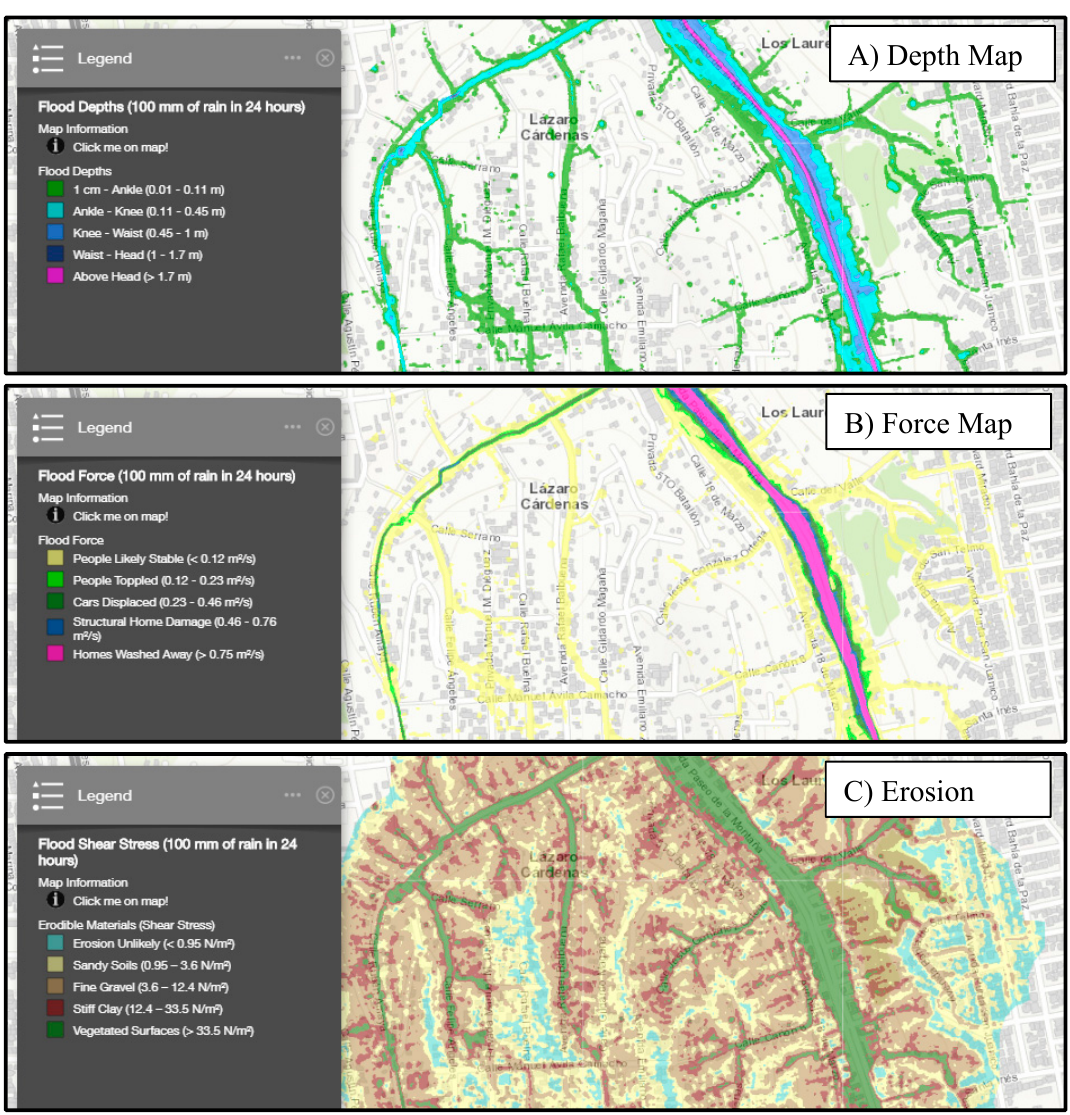
Figure 4. Visualization of three aspects of pluvial flood flashing (PFF) from 100 mm of rainfall over 24-h: ( A ) maximum flood depth, ( B ) maximum flood force, and ( C ) maximum shear stress visualizations accessed from the Los Laureles Canyon (LLC) online flood hazard viewer, which also includes similar maps for cases involving 50 and 80 mm of rainfall representative of more frequent events. These visualizations are accessible through an online GIS, so browsers can pan, zoom, change the base map, and switch between maps [64].